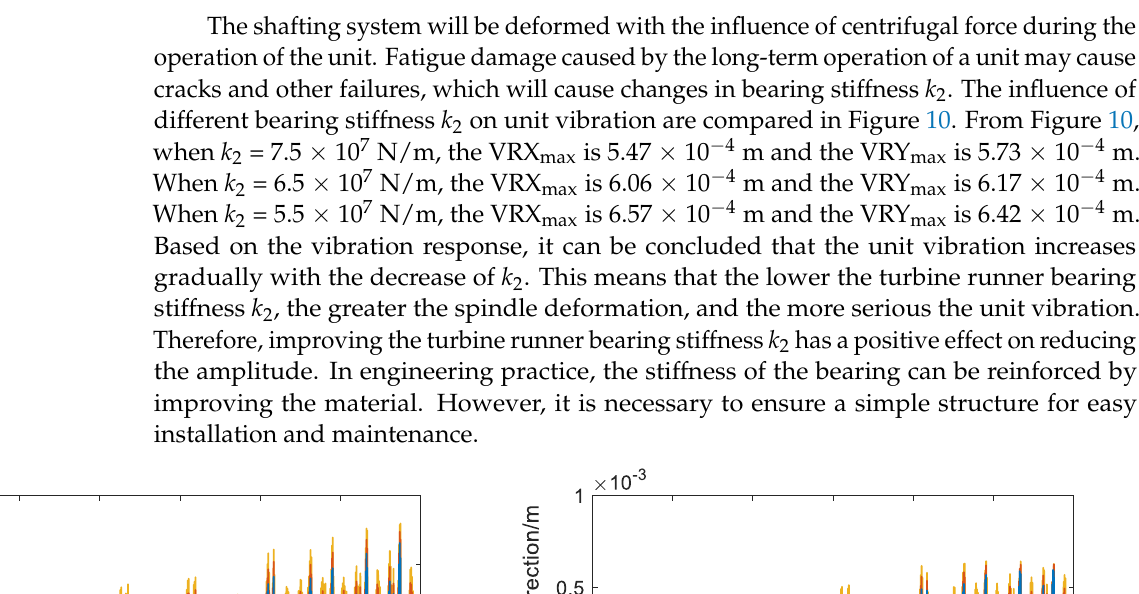
Figure 9. Shafting vibration response in the X and Y directions of the unit with different e 2 ; ( a ) shafting vibration response in X direction; ( b ) shafting vibration response in Y direction.